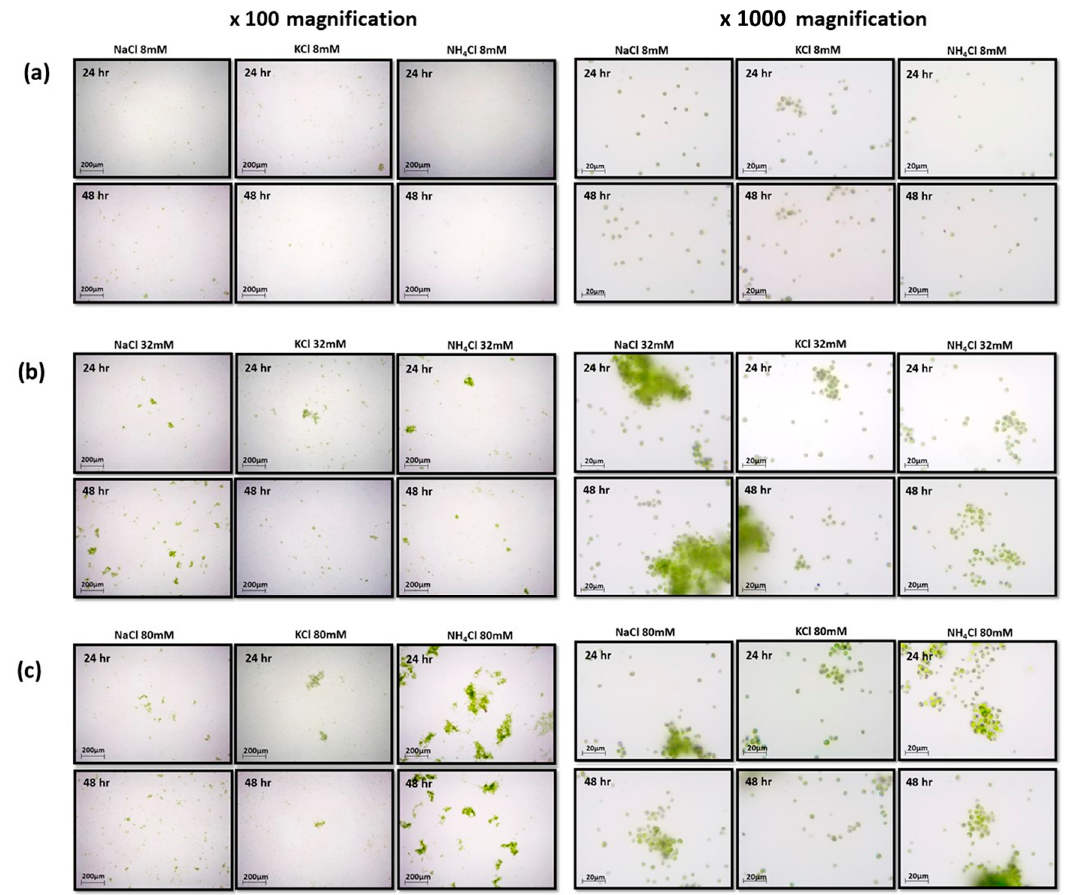
Figure 8. Microscopic images (×100 and ×1000 time magnification) of the algal FS after 48 h of exposure to different salt concentrations (NaCl, KCl and NH 4 Cl): ( a ) 8 mM, ( b ) 32 mM, and ( c ) 80 mM.